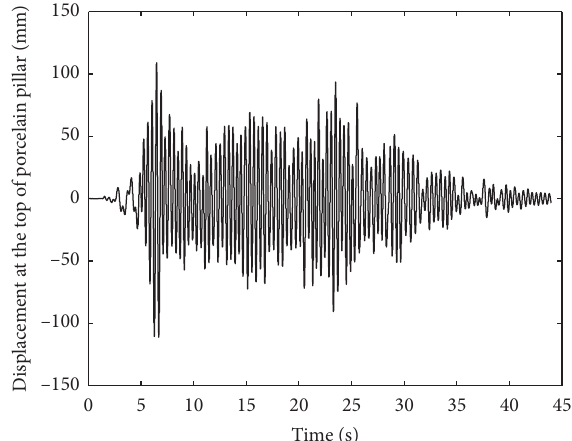
Figure 15: Maximum stress at the bottom of porcelain pillar ( a � 0.1g, η � 0).